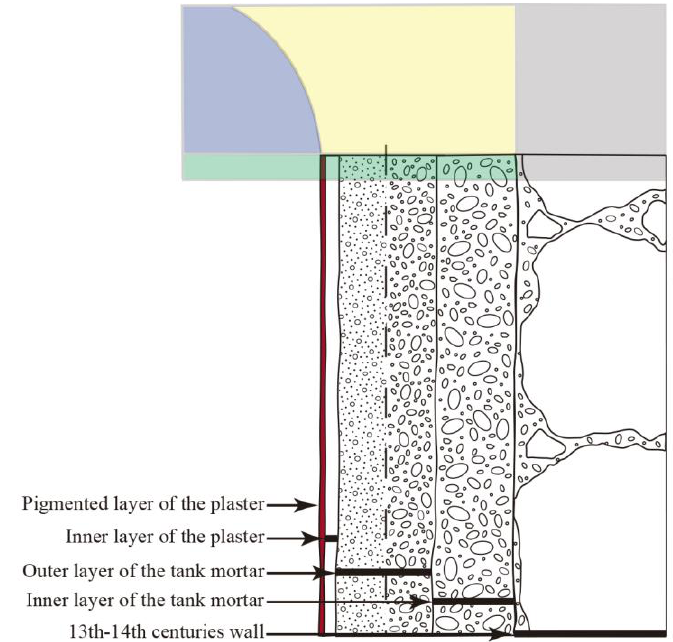
Figure 10. Schematic image of the multilayer application technique for mortars in Amaiur Castle cistern. The cistern tank is shown in green, the vault lunette is shown in blue, the barrel vault is shown in yellow, and the 14th–15th centuries wall is shown in black.